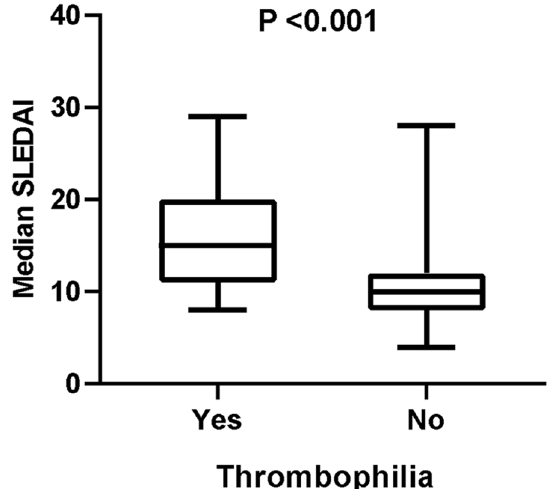
Fig. 2 Correlation of SLEDAI with thromboembolic events in SLE patients without